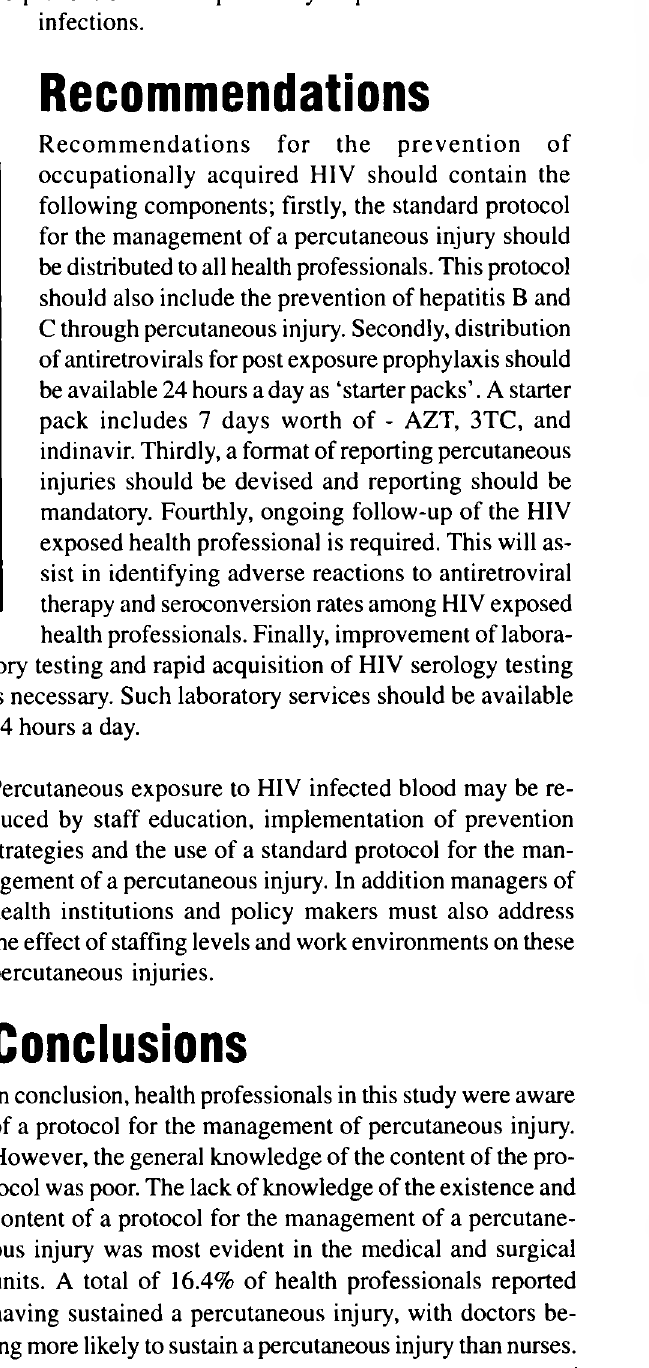
Table 3: Means of sustaining the percutaneous injury